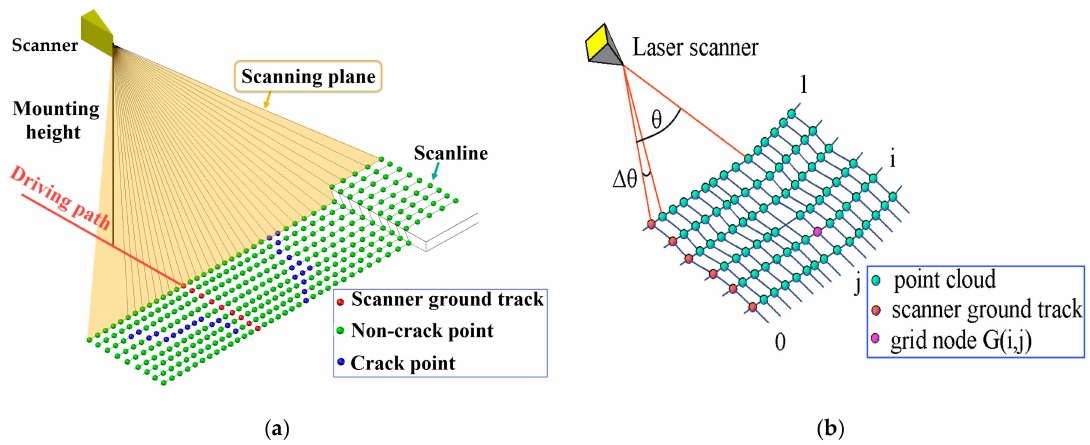
Figure 2. The connectivity provided by the arrangement of mobile laser scanning (MLS) point clouds. ( a ) The arrangement of MLS point clouds collected by a two-dimensional (2D) scanner with equal incremental angle. ( b ) Create a Time grid (Tgrid) for MLS point cloud by using the scanning line and scan angle information.